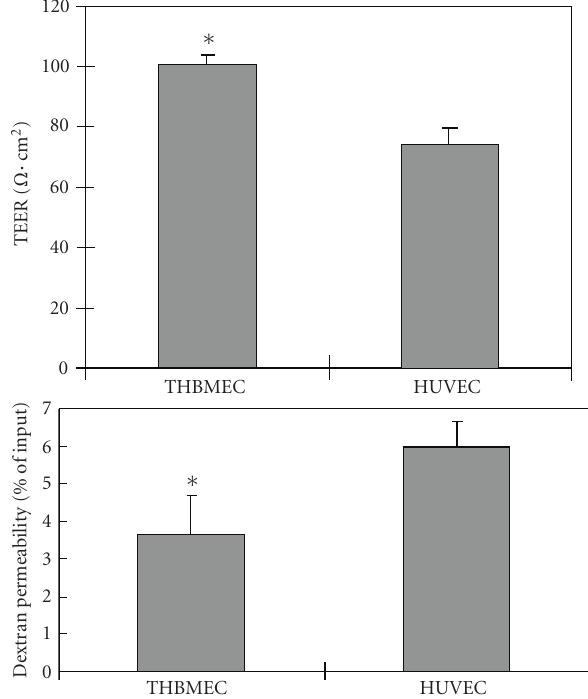
Figure 2: Confluent THBMEC cultures have a higher TEER and lower solute permeability than HUVEC. THBMECs and HUVECs were cultured to confluence on 24-well collagen-coated Transwell TM inserts. TEER (a) was measure using an EVOM voltohmmeter. THBMECs possess higher TEER values. Solute permeability (b) was assessed by adding 100 μ l of 1mg/mL fluoresceinated dextran-70 in Transwell TM inserts. Fluorescent recovery in the lower chamber (well) was measured after 15 minutes as stated in Section 2. Triplicate wells were mea- sured and inserts without cultured endothelial cells were used as controls (data not shown). THBMEC cultures demonstrate a lower solute permeability. ∗ indicates P < . 05 compared with